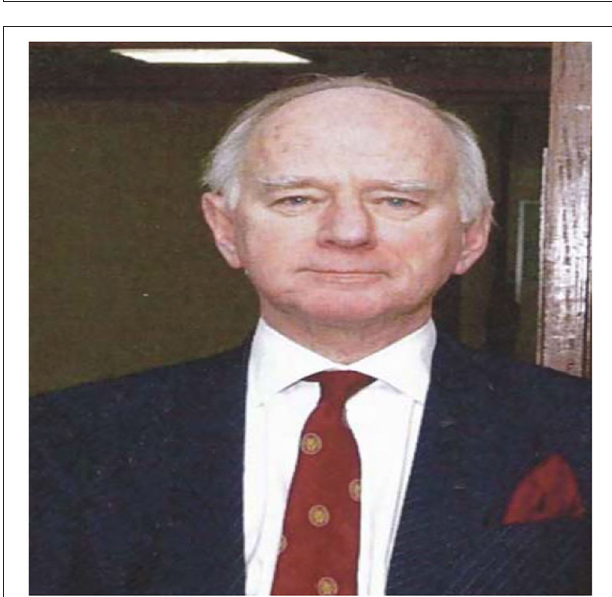
FIGURE 2 | Professor Ray Fitzgerald MA FRCS FRACS—Trinity College Dublin, Ireland.